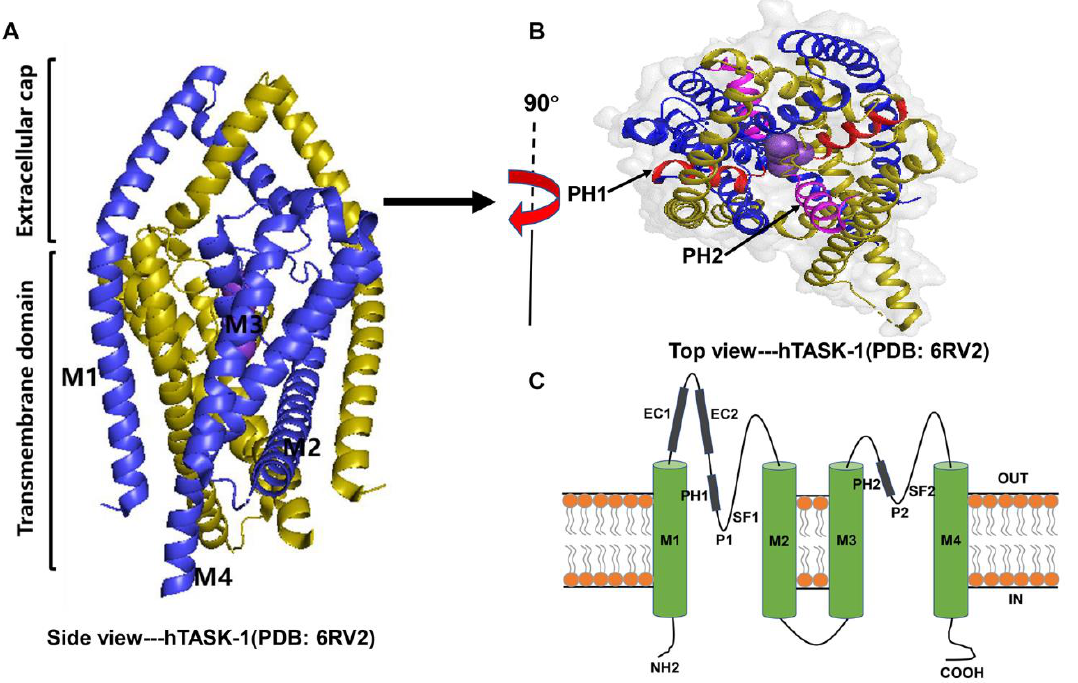
Figure 1. The structure and topology of the hTASK-1 channel. ( A ) Side view from the cell membrane. The hTASK-1 channel (PDB code 6RV2) consists of two homologous subunits, which are shown in blue and olive. The four transmembrane fragments (M1 – M4) and two extracellular cap regions are labeled. ( B ) Top view of the hTASK-1 channel from the extracellular face, with the two pore helices (PH1 and PH2) highlighted in red and magenta in each subunit, respectively. The purple spheres are potassium ions. ( C ) Schematic topology of TASK channels: EC1 and EC2 are extracellular caps 1 and 2; P1 and P2 are pore regions 1 and 2; SF1 and SF2 are the selectivity filter of P1 and P2; OUT and IN represent the extracellular and intracellular surface, respectively.